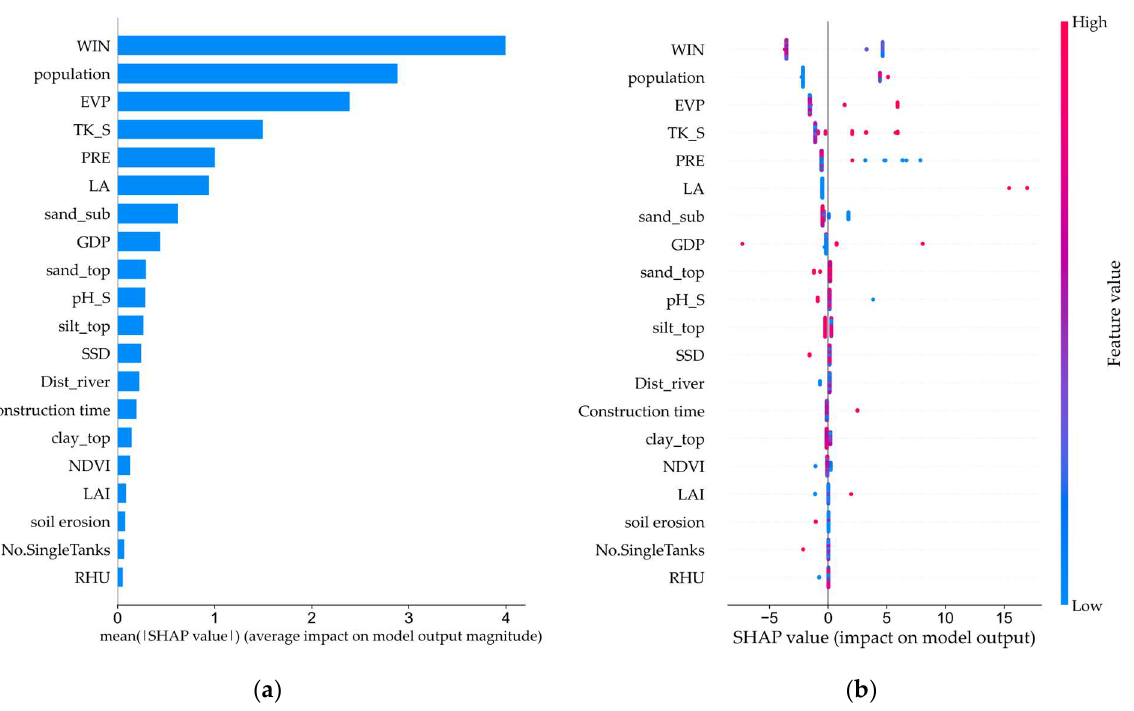
Figure 4. Results of SHAP analysis of the BO-GBDT model. ( a ) Bar diagram showing the feature variable importance.; ( b ) SHAP summary plot of feature variables.